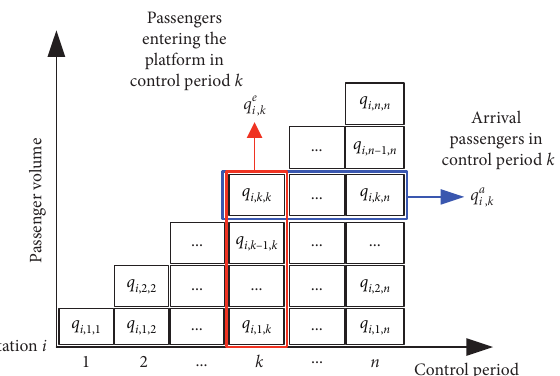
Figure 3: Illustration of the passenger flow control